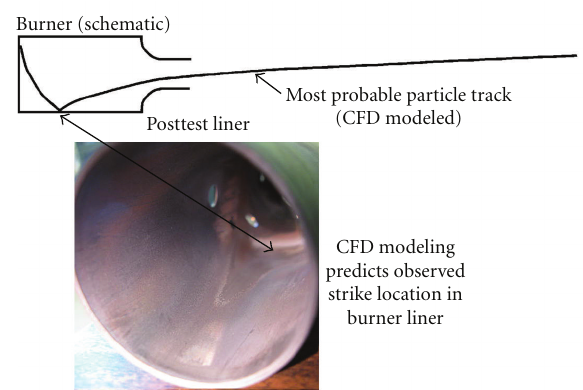
Figure 4: Model predictions of most probable location of particle strikes on wall correspond with eroded region seen in actual rig. Location of particle strikes/eroded region is about 0.05m from the end of the liner/beginning of the